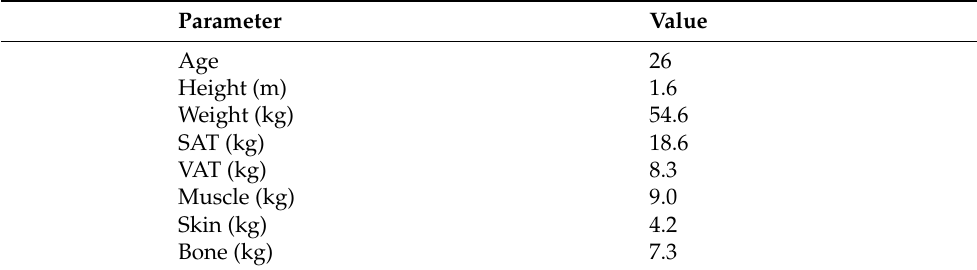
Table 2. Parameters of the human body